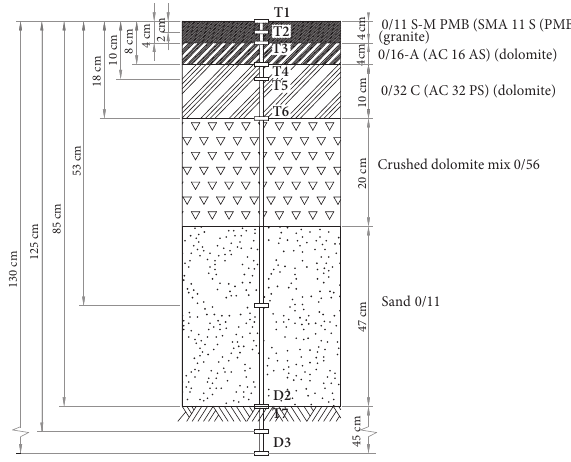
Fig. 1. Road pavement structure No. 12 equipped with temperature sensors